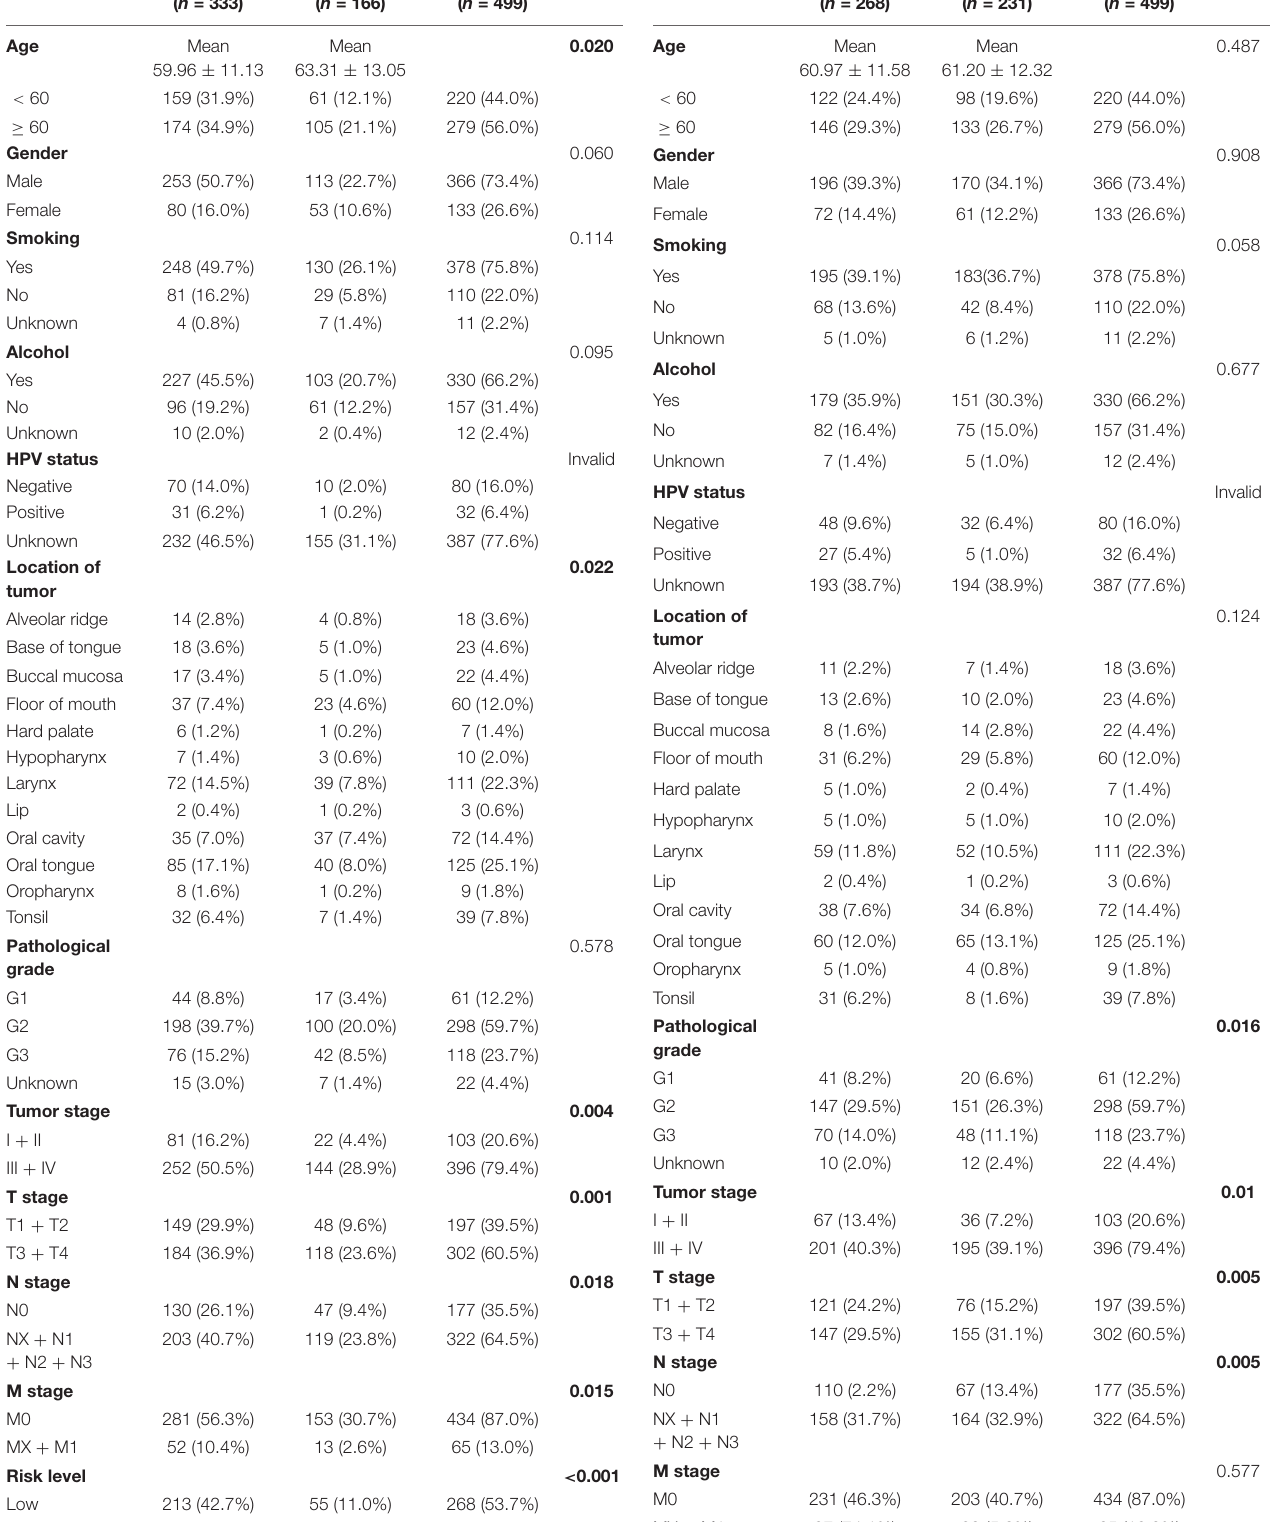
TABLE 2 | The relationship between clinical outcome and clinical factors. TABLE 3 | The relationship between risk level and clinical